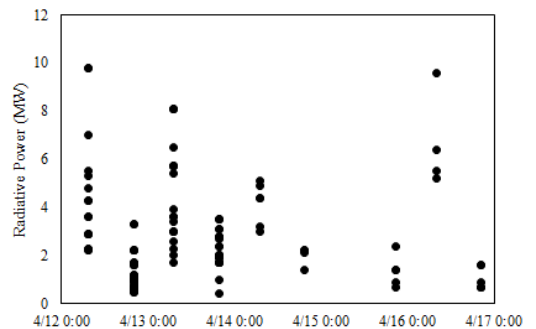
Figure 8 . Radiative power (MW) of fire pixels detected in Valmiki, India by